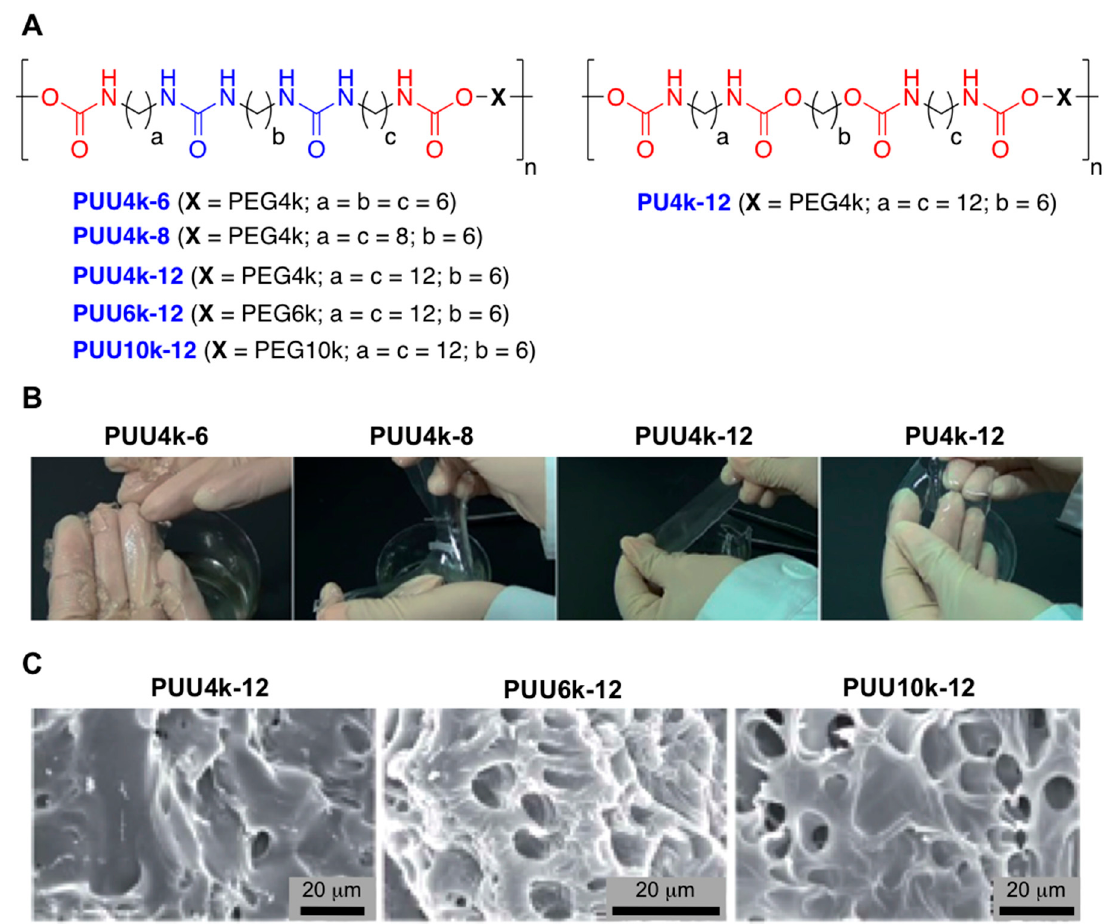
Figure 10. ( A ) Chemical structure of linear PUU and PU (PU4k-12) copolymers with various lengths of hydrophobic alkyl spacers and PEG chains. ( B ) Photo images of the PEG4k based PUU and PU supramolecular hydrogels. ( C ) SEM micrographs showing the cross-sections of the freeze-dried fully swollen PUUS hydrogels formed by PUU4k-12, PUU6k-12, and PUU10k-12 copolymers. Adapted with permission from Reference [63]. Copyright 2015 Royal Society of Chemistry.